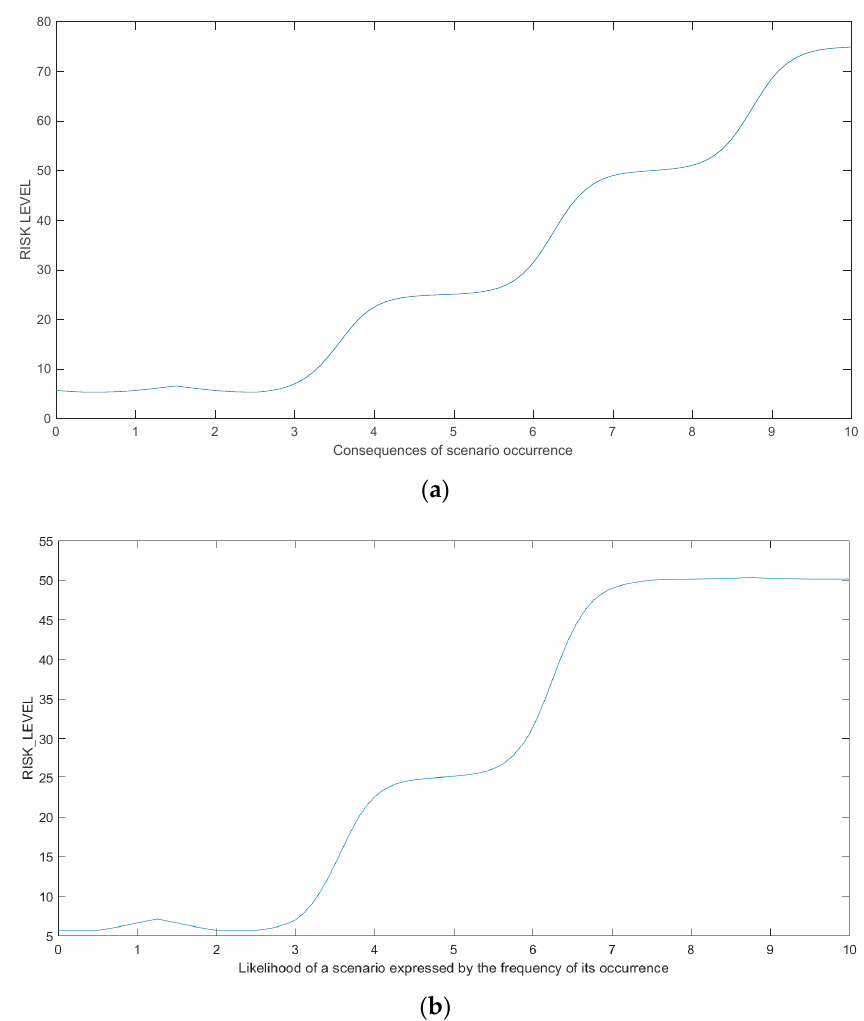
Figure 9. Dependencies between the input function course on the obtained risk level index: ( a ) Function of consequences of scenario occurrence; ( b ) Function of likelihood of scenario expressed by frequency of its occurrence.